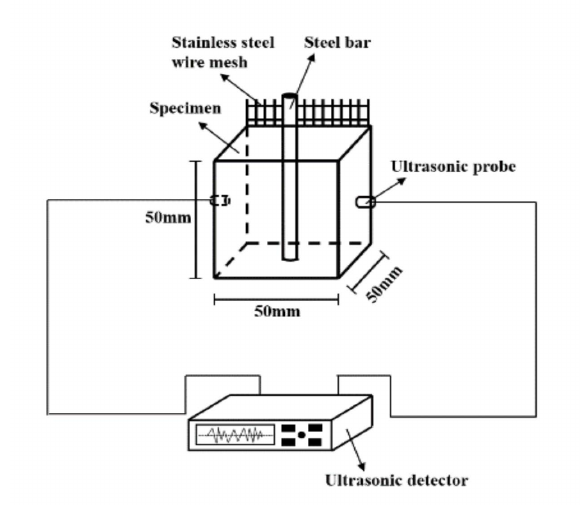
Figure 1. The schematic diagram of ultrasonic measurement.